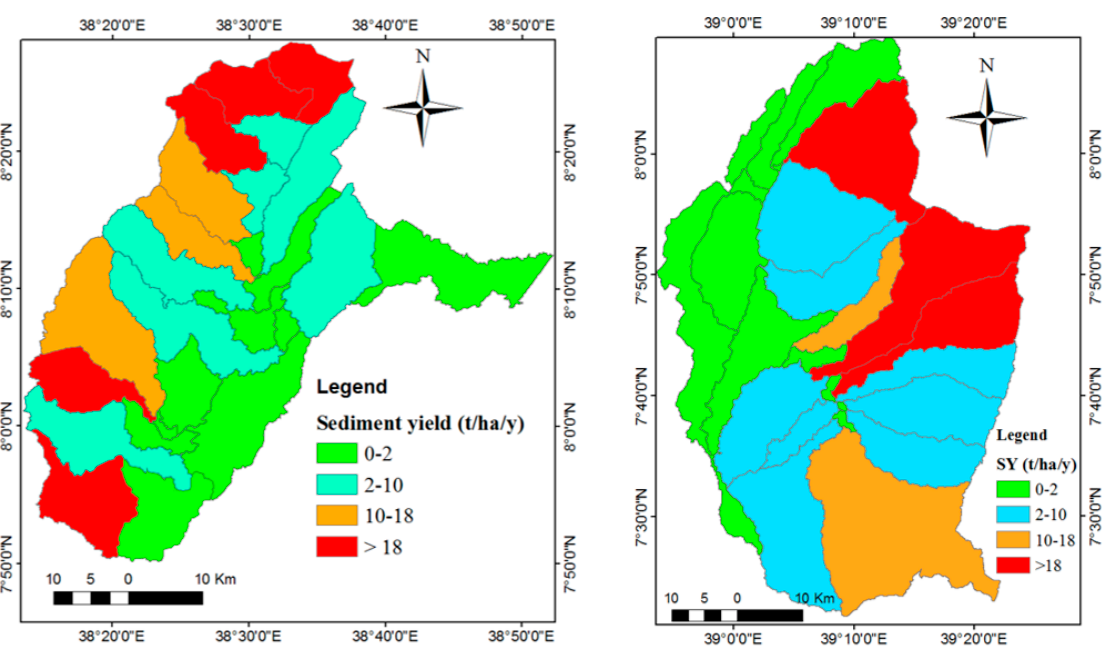
Figure 8. Spatial distribution of soil loss severity classes: Maki ( Left ) and Katar ( Right ) sub- watersheds.